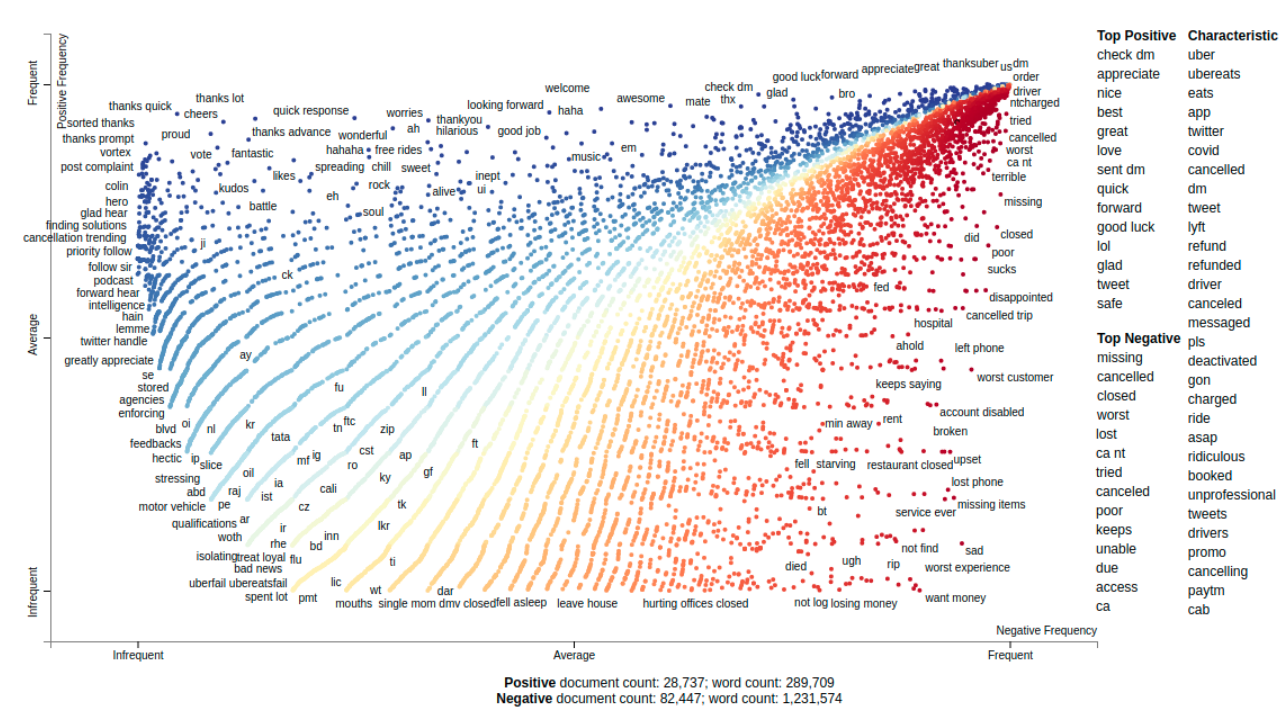
Figure 5. Frequency of words for both Positive and Negative categories. On the right, most frequent words for Positive (Top Positive) and Negative (Top Negative), and both